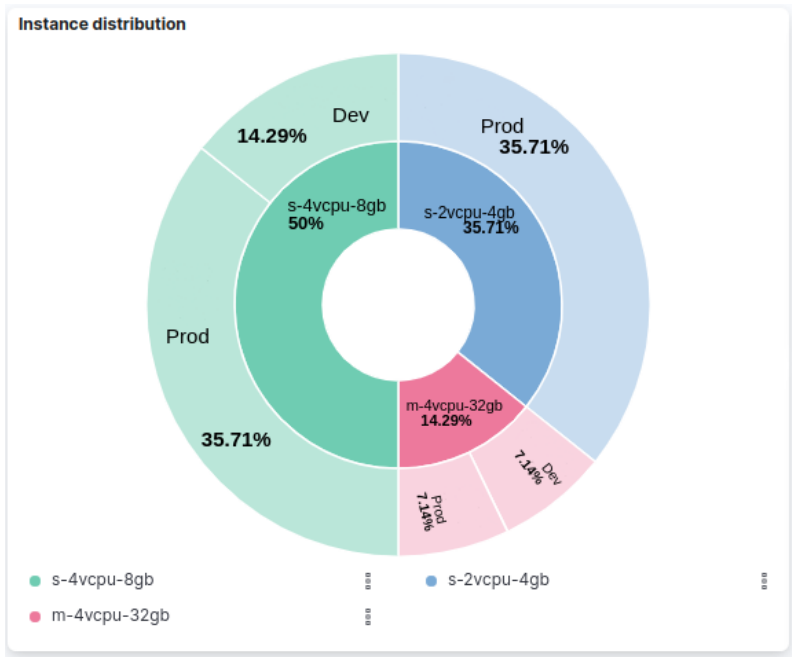
Figure 5. VM instance distribution per